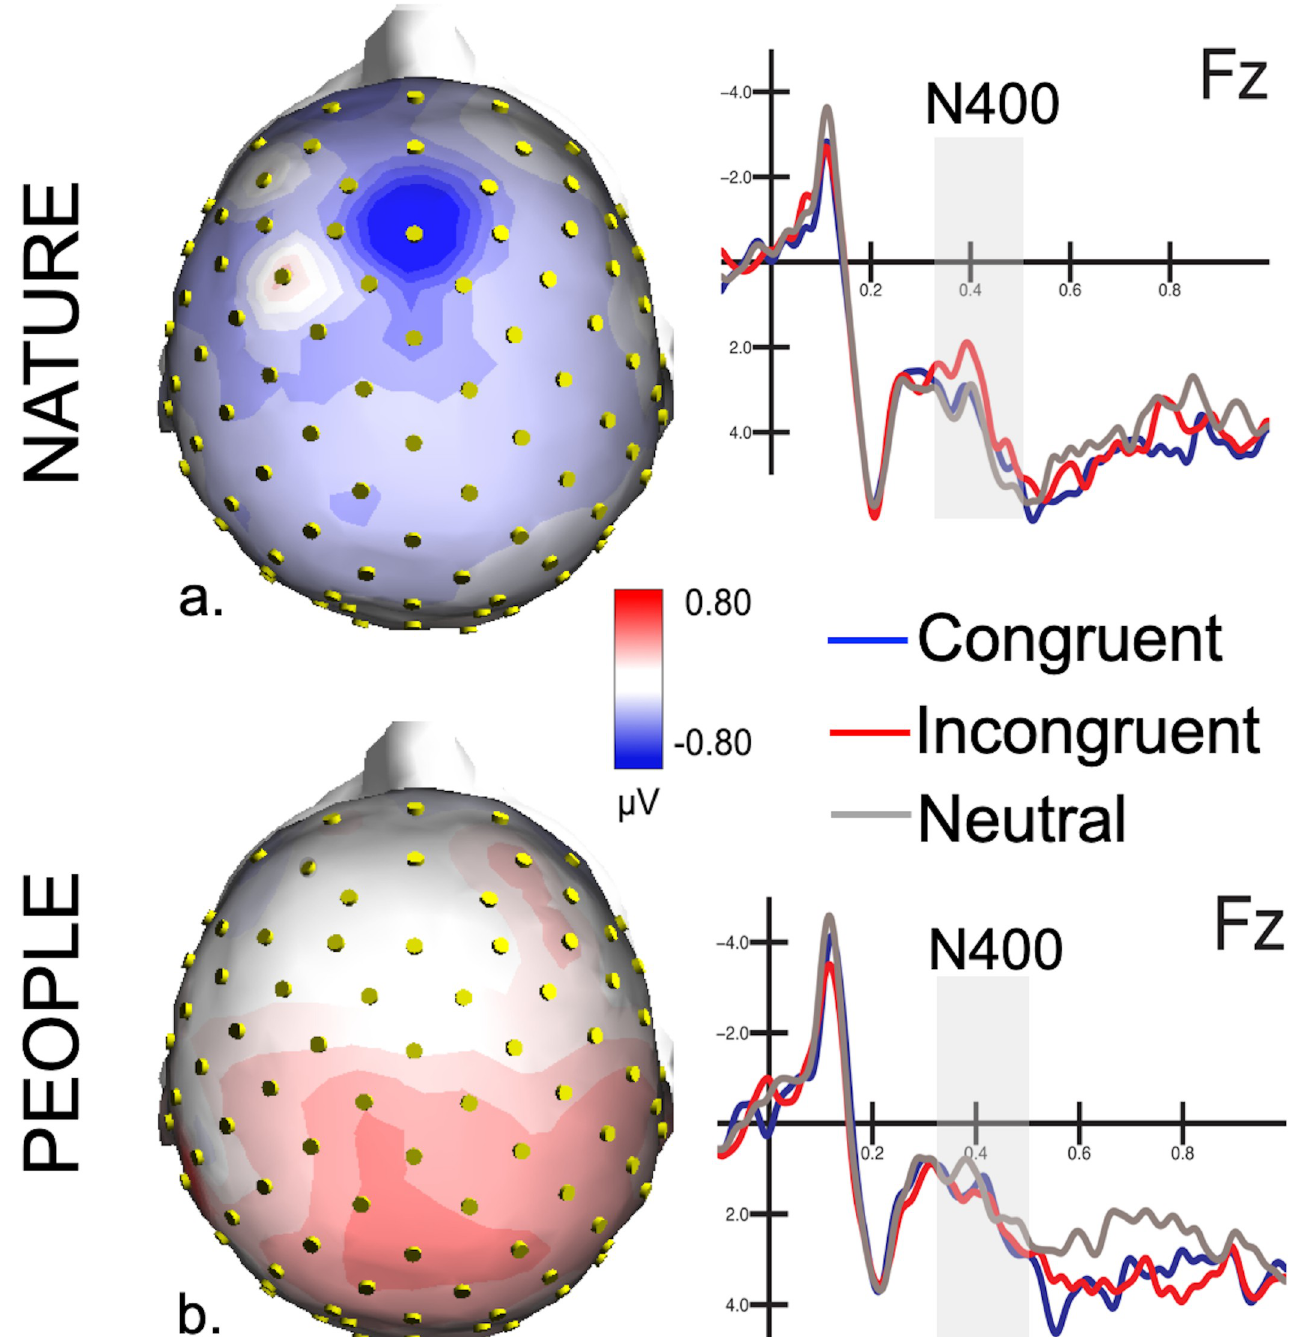
Fig 3. N400 topographical map. Topographical distribution of the differential voltage (Incongruent–Congruent) recorded between 350 and 550 ms post- stimulus and ERP waveforms recorded at frontal sites in response to Congruent, Incongruent and Neutral sentences; The top figure (a) shows results in the “Nature” group; the bottom figure (b) in the “People”